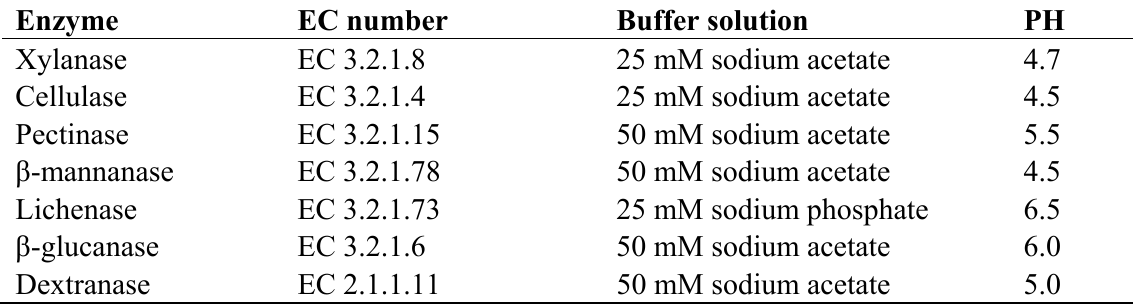
Table 2. Digestion buffers for various enzyme digestion modified from the operation